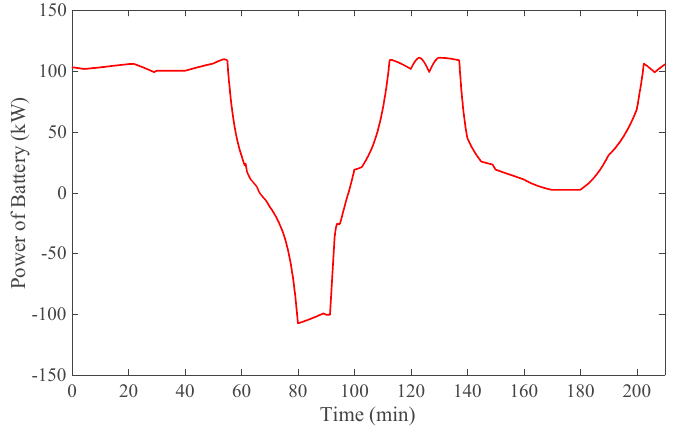
Figure 16. Optimized output power of the battery.